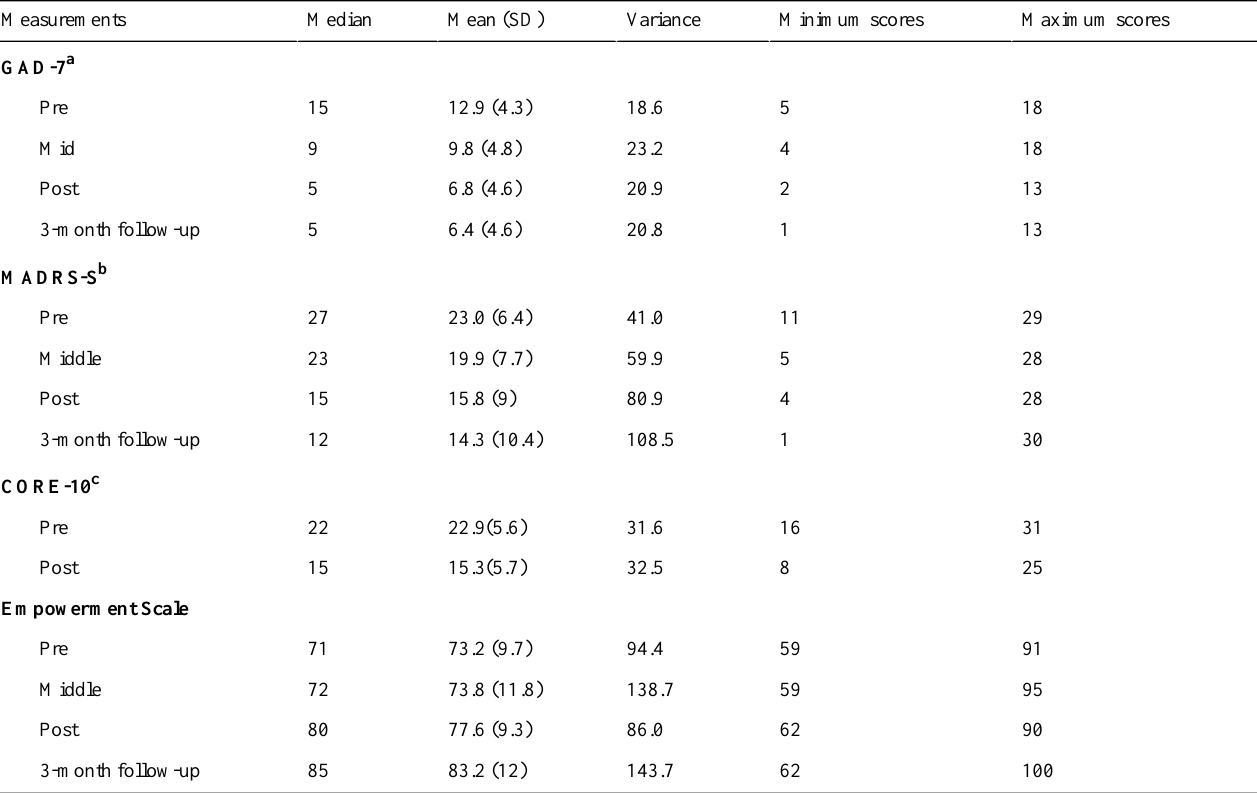
Table 3. Descriptive statistics for measurement points on GAD-7, MADRS-S, CORE-10, and the Empowerment